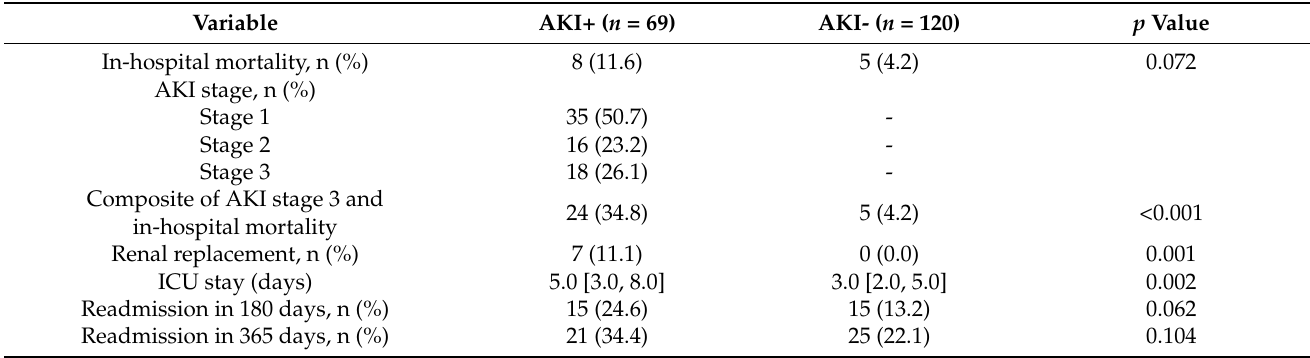
Table 2. In-hospital outcome and readmission rate of patients admitted due to heart failure with or without